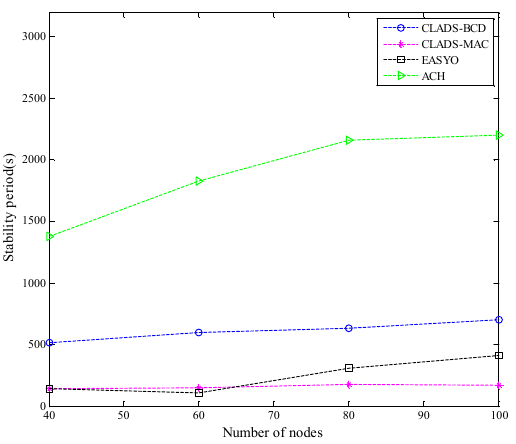
Figure 1. Stability period with varying number of nodes.